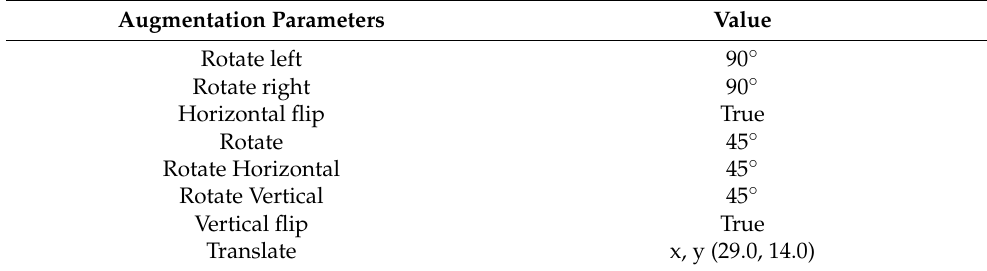
Table 4. Value of data augmentation